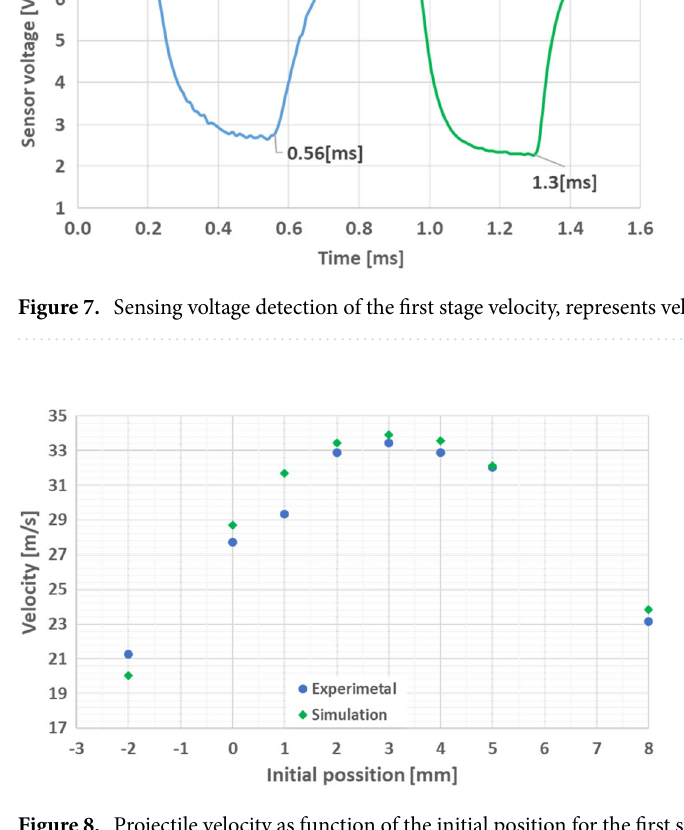
Figure 8. Projectile velocity as function of the initial position for the first stage. Simulation and experiment